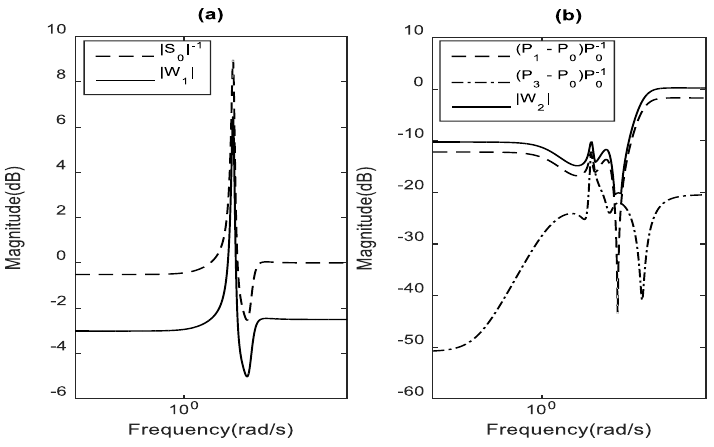
Figure 10. Weighting functions W 1 and W 2 : ( a ) | W 1 ( j ω ) | plot; and ( b ) | W 2 ( j ω ) | plot.